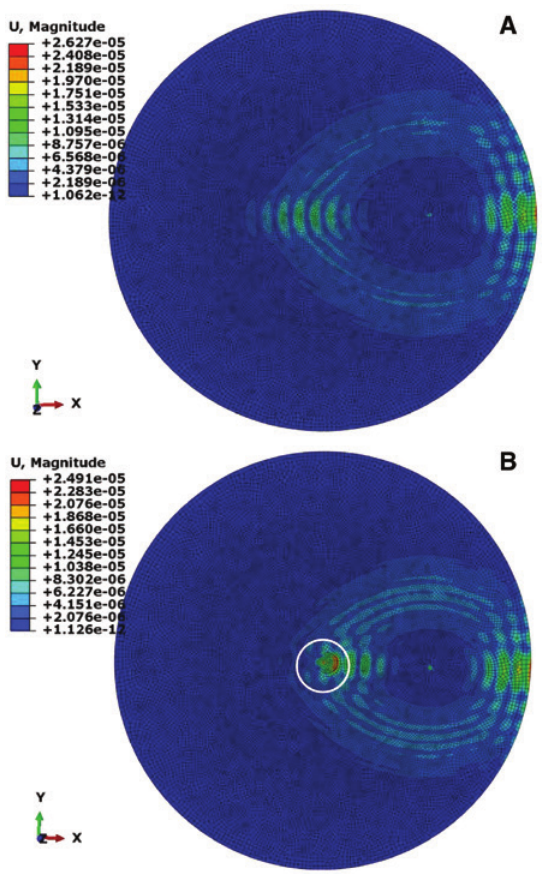
Figure 3: Propagation of Lamb wave in two different models: (A) an unflawed model and (B) the flawed model with a hole in the center.